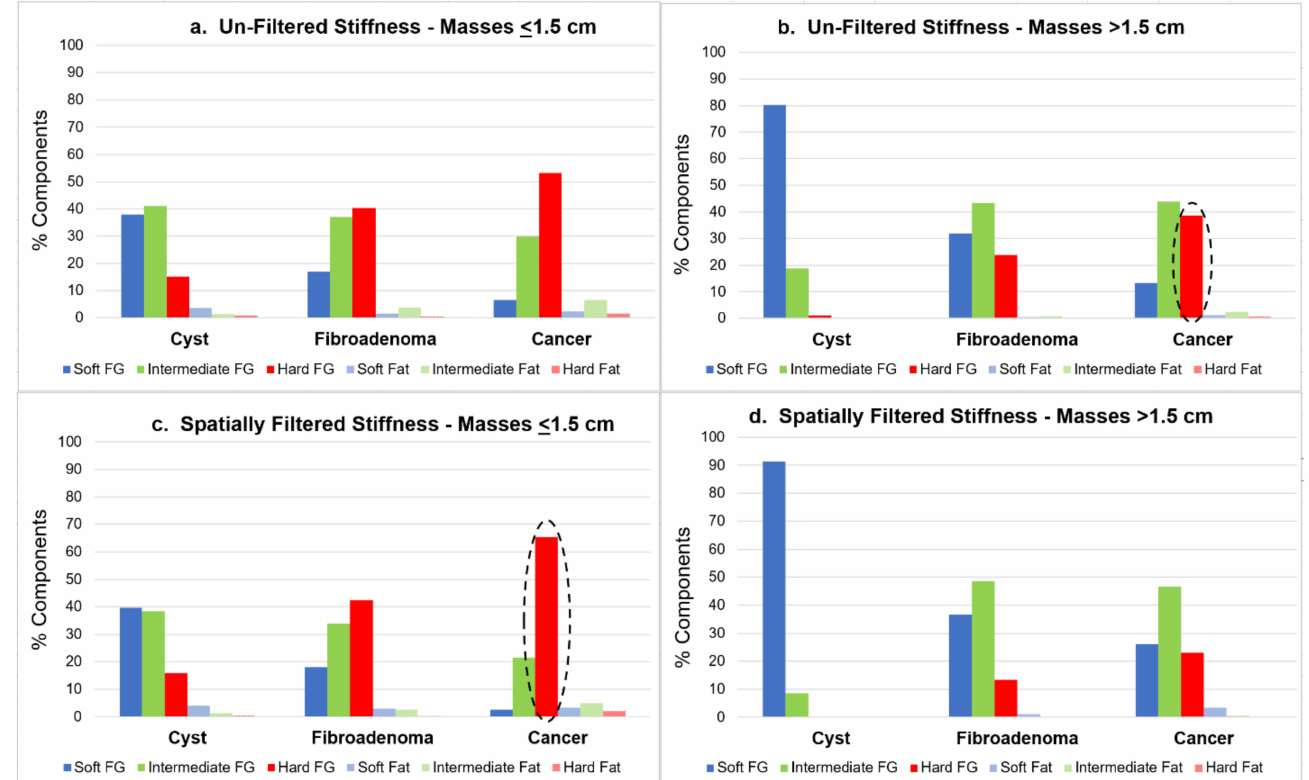
Figure 5. ( a – d )-Graphic distribution of the six relative stiffness components (%) for masses ≤ 1.5 cm ( a / c -left) and >1.5 cm ( b / d -right), using un-filtered (top row) and spatially filtered (bottom row) renderings (darker bars = fibroglandular = FG; lighter bars = Fat). Smaller masses show greater relative volume of hard components (red) than larger masses, and greater hardness for cancers than fibroadenomas when using spatial filtering ( c ; dashed oval). Conversely, larger masses show greater hard components for the default unfiltered stiffness images, especially cancers ( b ; dashed